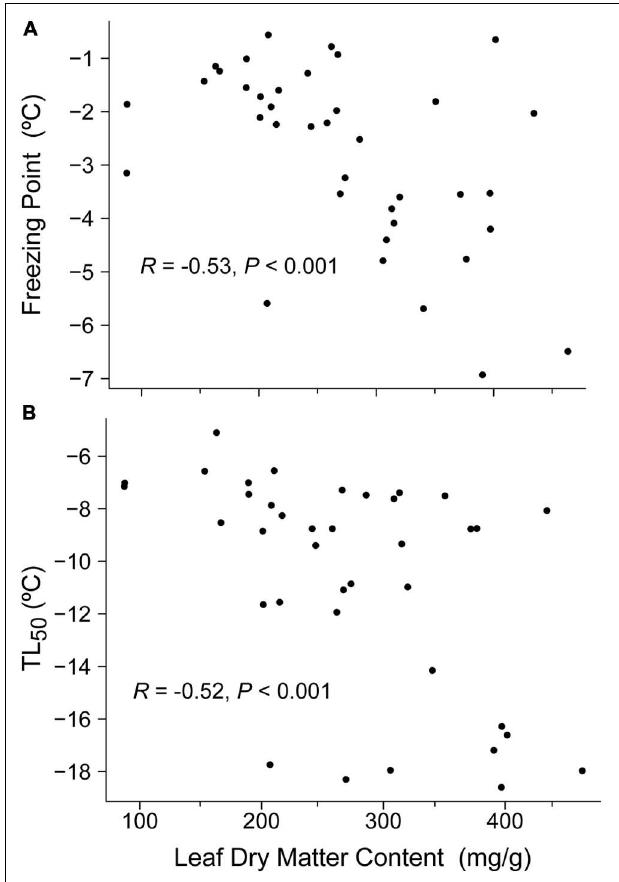
FIGURE 3 | Relationships between leaf dry matter content (LDMC, mg/g) and: (A) freezing point (FP, ◦ C) and (B) freezing temperature damage (LT 50 , ◦ C). Results of Spearman’s correlation are